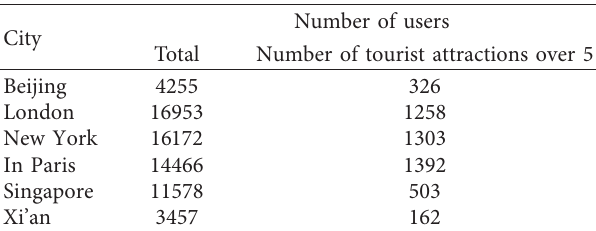
Table 5: Statistics of travel data of real and reliable users in different cities.